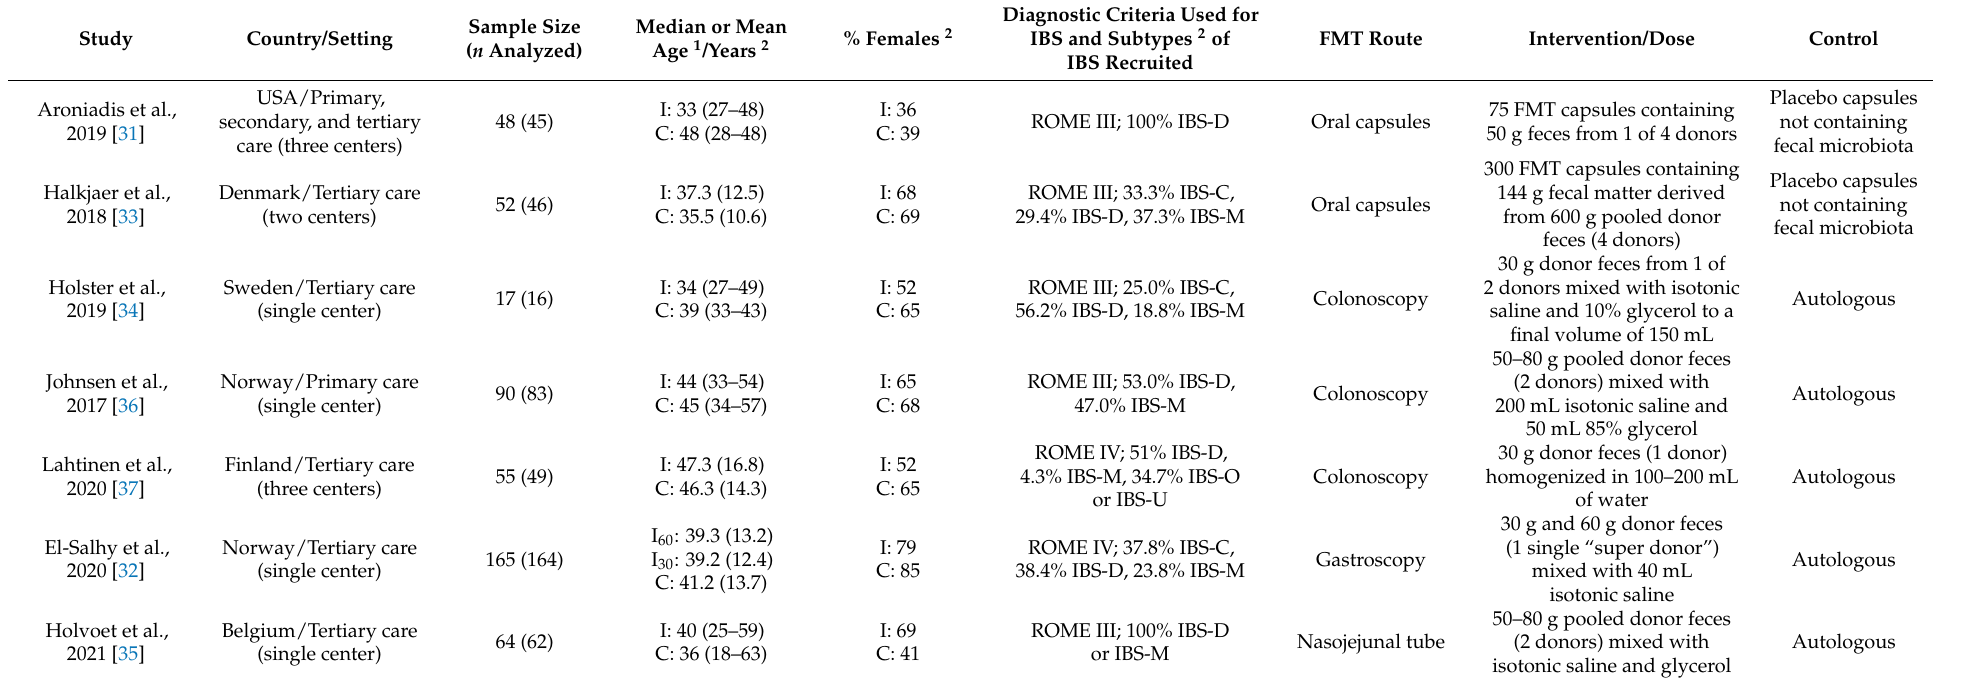
Table 1. Characteristics of the studies included in the systematic